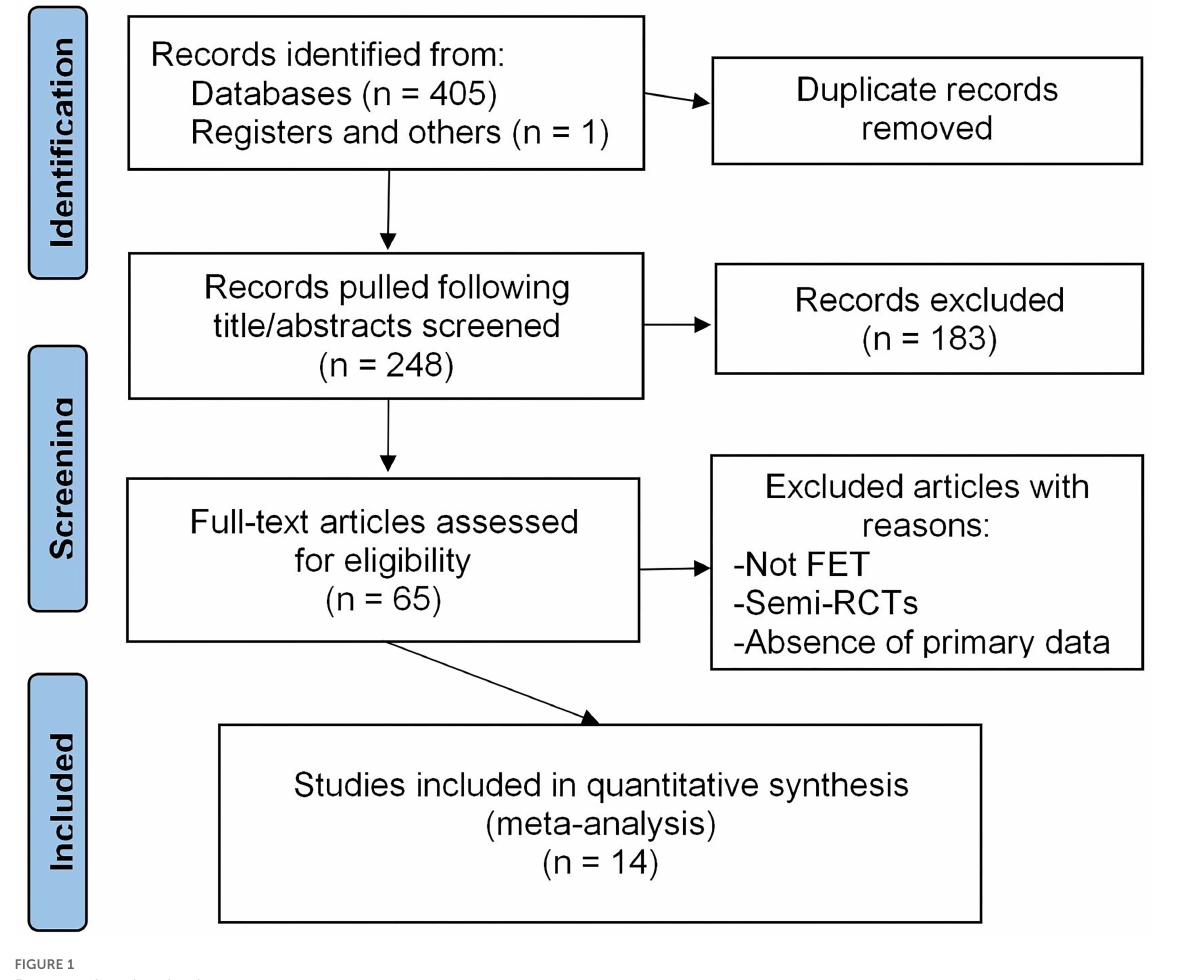
FIGURE1 Process of study